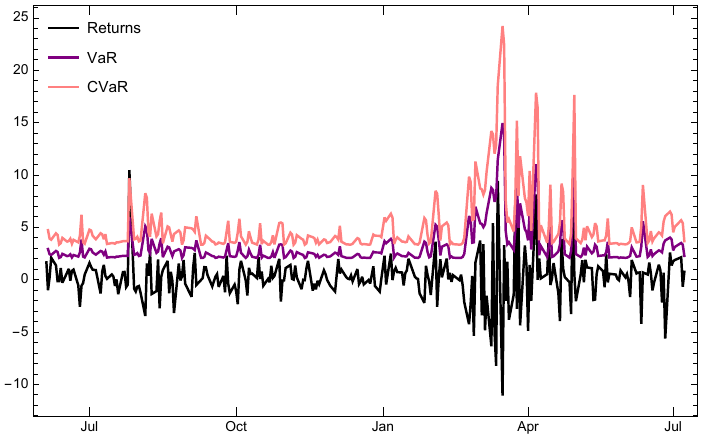
Figure 5. Results of risk comparisons (based on Laplace distribution) by the pre-determined confi- dence level α = 90% for the NASDAQ:GOOG. The horizontal and vertical axes stand for the time and risk values and returns, respectively.